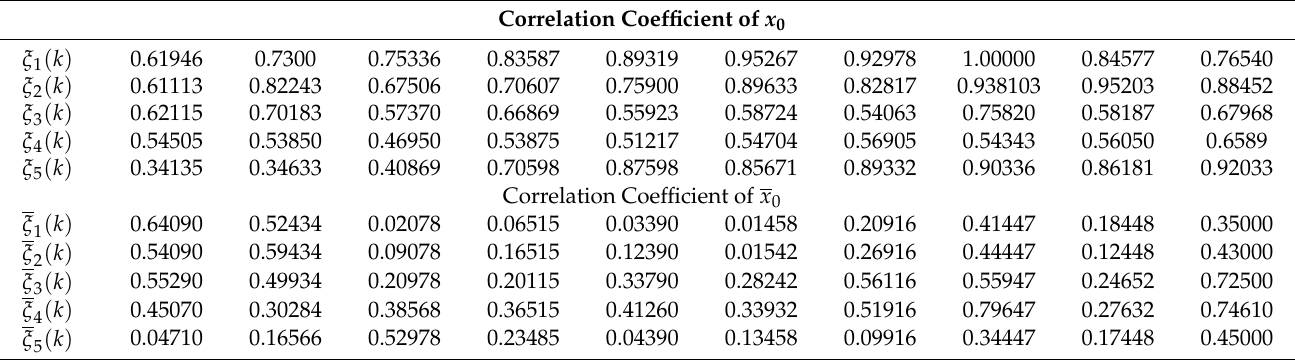
Table 6. Correlation coefficients between RCI, PIT and progress on the treatment of the five main types of